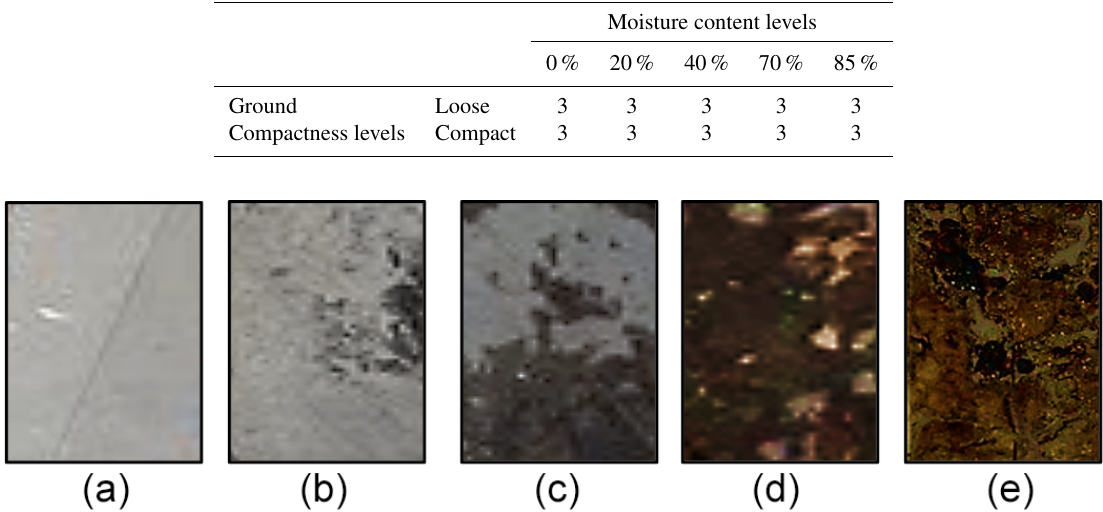
Figure 2. Visual images of specimens after 2304h exposition at different moisture contents; 0% (a) , 20% (b) , 40% (c) , 70% (d) and 85% (e) . Ground density has no significant evidence on visual inspection.